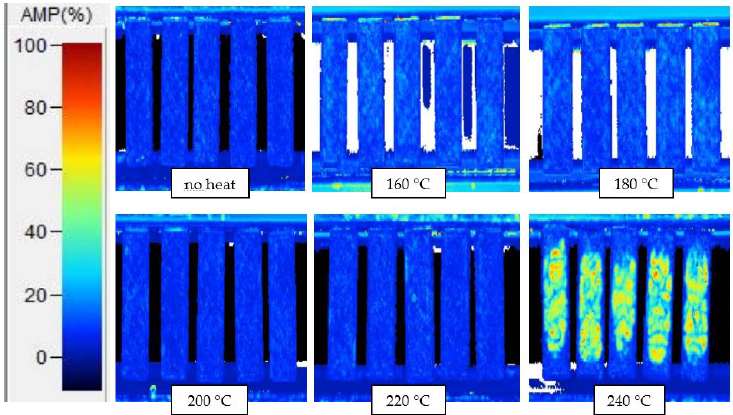
Figure 4. C ‐ scans showing amplitude of interior reflections from short ‐ beam samples exposed to Figure 4. C-scans showing amplitude of interior reflections from short-beam samples exposed to various temperatures for 1 h. various temperatures for 1